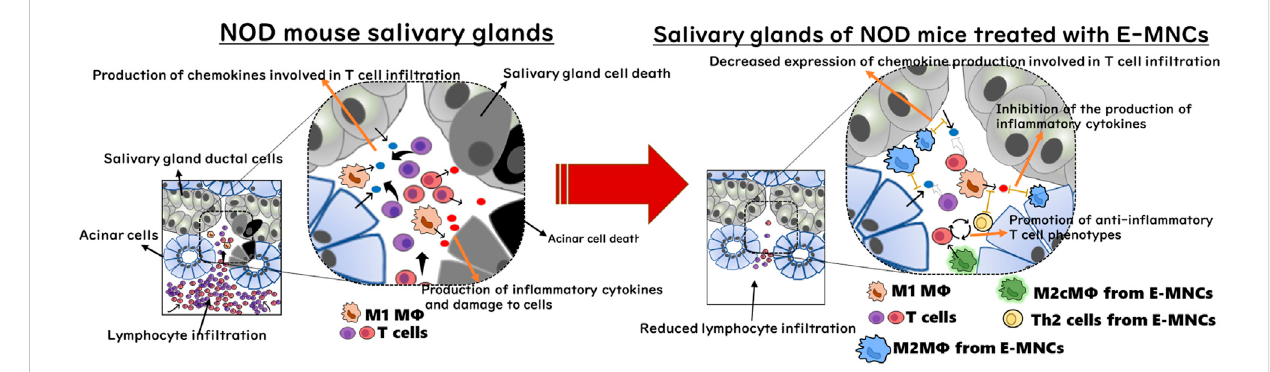
FIGURE 9 Diagram of the cellular mechanism of E-MNC transplantation at the onset of SS in NOD mice. E-MNCs function in a paracrine manner to inhibit chemotaxis of pathogenic T cells and improve the tissue microenvironment via the immunomodulatory effects of M2 macrophages and/or Th2 cells among E-MNCs during the initial stage after